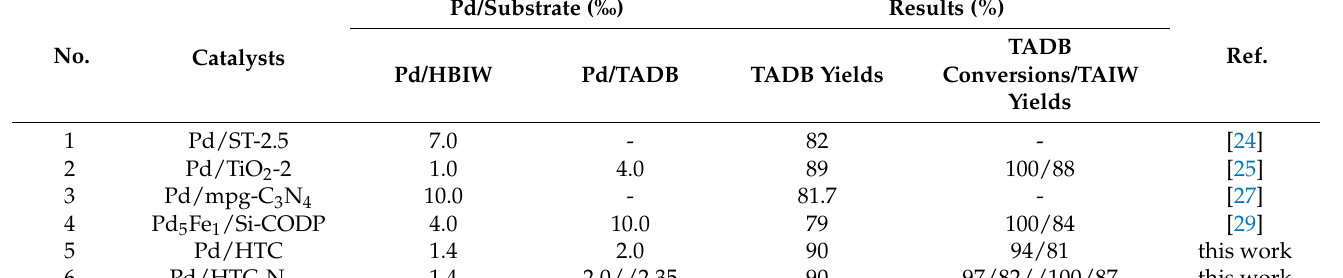
Table 4. Comparison of the catalyst’s activities in the debenzylation reactions of HBIW and TADB.